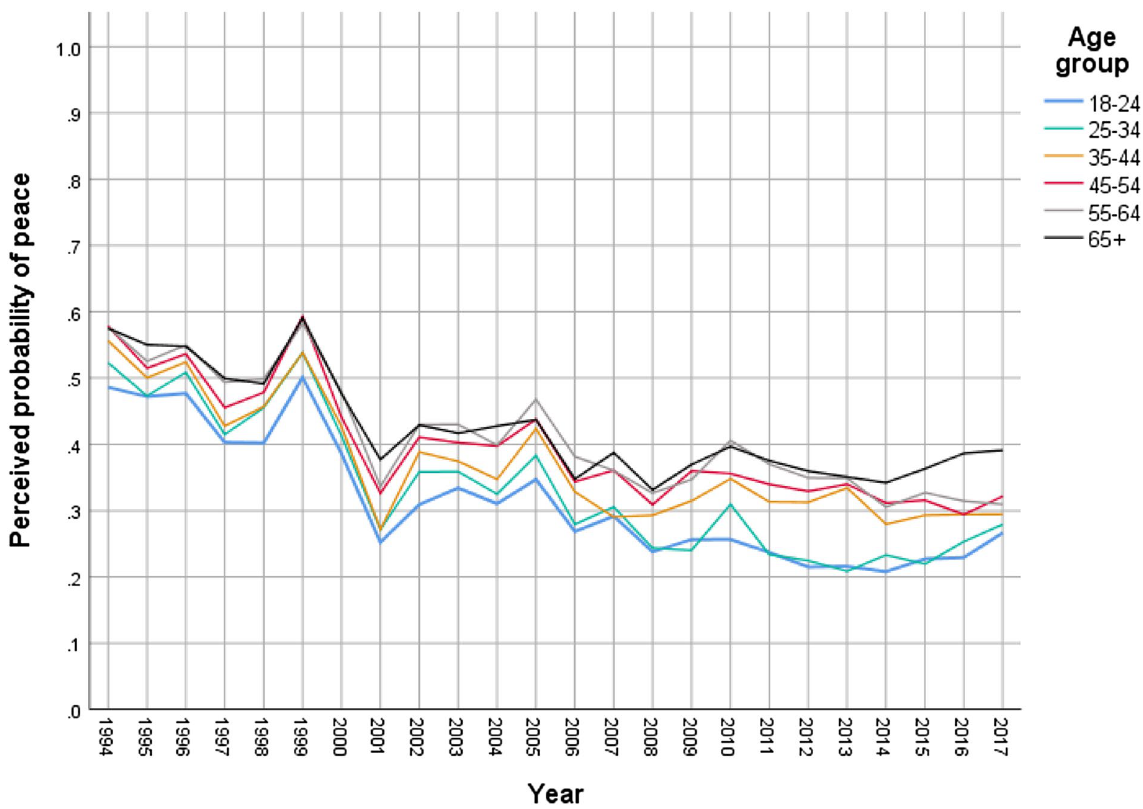
Figure 1. Yearly means of perceived probability of peace across age groups in surveys on Israeli Jews from 1994 to 2017 (1 indicates the highest level). Data courtesy of the Guttman Center for Public Opinion and Policy Research at the Israel Democracy Institute. Age groups and yearly means of perceived probability of peace are used for visualization of the linear trend. Analyzes are conducted using monthly ratings of perceived probability of peace and the continuous age